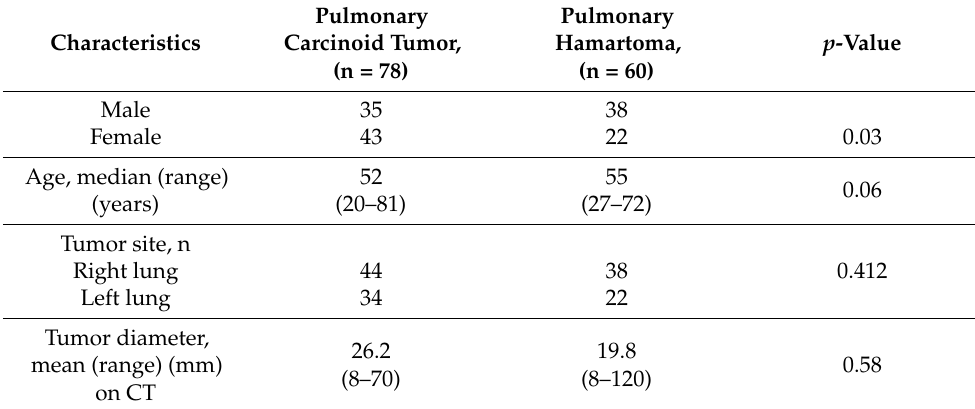
Table 1. Clinical characteristics of the patients.